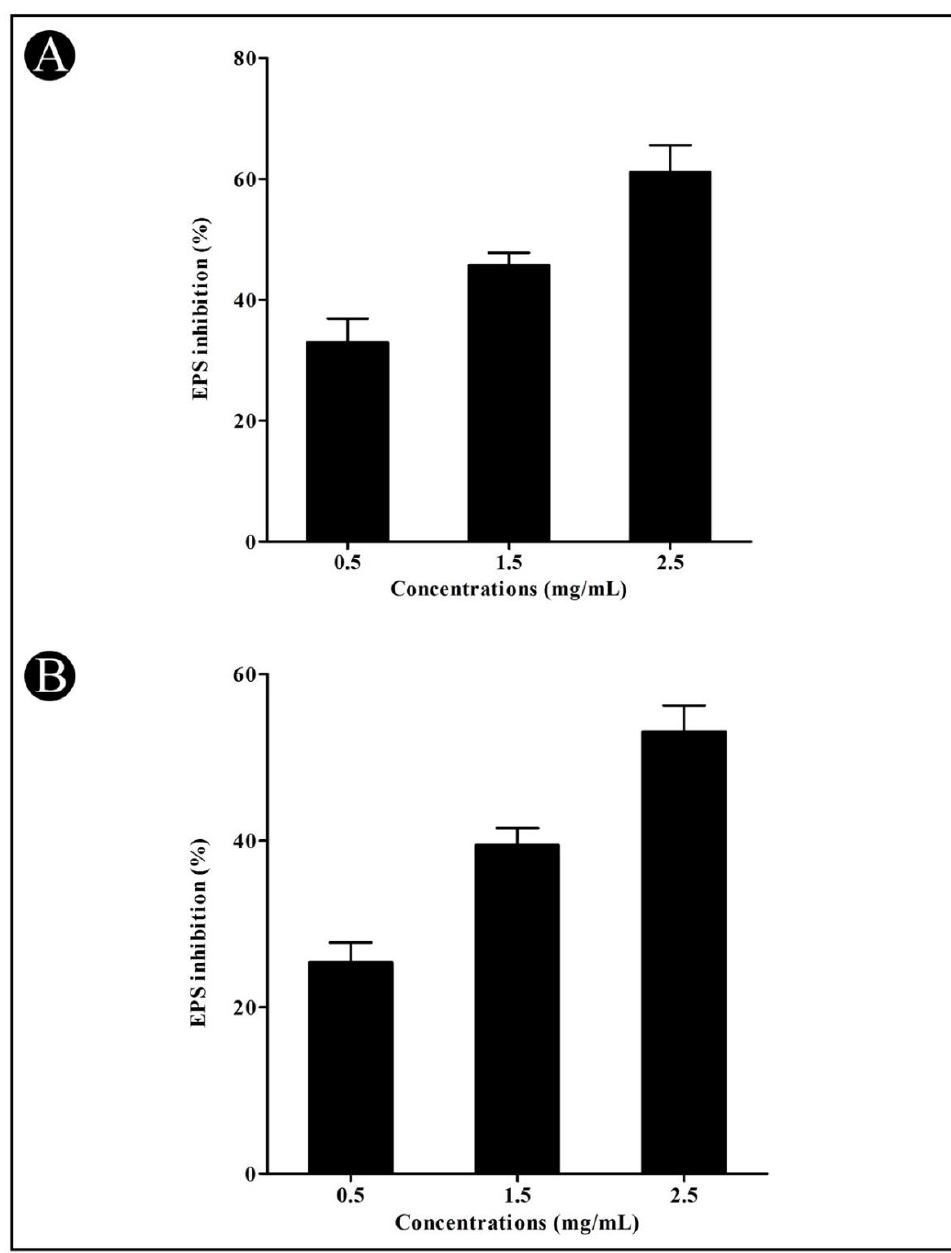
Figure 4. Inhibition of swarming motility and EPS production by the crude L. plantarum biosurfactant at a sub-MIC concentration. Effect of the crude biosurfactant on EPS production in C. violaceum ( A ) and P. aeruginosa ( B ) at sub-MIC concentrations (0.5, 1.5, and 2.5 mg/mL).